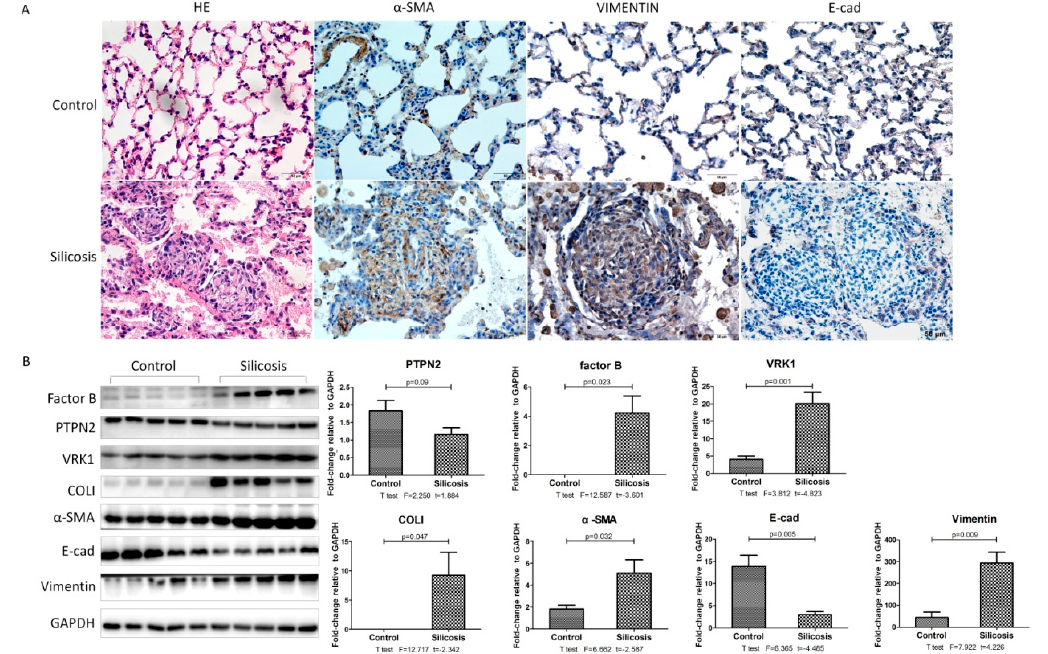
Figure 3. Observation of pathological changes in experimental rat 24Wsilicosis.( A ) Lung tissue stained with H&E and the expression of α -SMA, Vimentin, and E-cad in the lung tissue of the silicosis model after 24 weeks, measured by immunohistochemistry; Scale bars: 100 µ m. ( B ) Western blot and corresponding densitometry data of the expression levels of PTPN2, factor B, VRK1, Col I, and α -SMA in the lung tissue of the silicosis model after 24 weeks. Relative densities of PTPN2, factor B, VRK1, fold-change of specific bands in the control group. Bar graphs are the mean ± SD of two separate experiments. Statistical analysis was performed using a t -test with